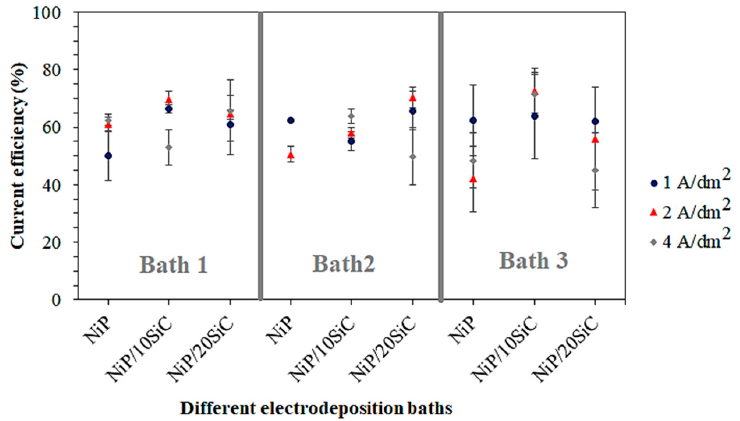
Figure 1. Effect of SiC loading, SDS, saccharin as well as current density on current efficiency of Figure 1. E ff ect of SiC loading, SDS, saccharin as well as current density on current e ffi ciency of electrodeposition NiP coating. electrodeposition NiP